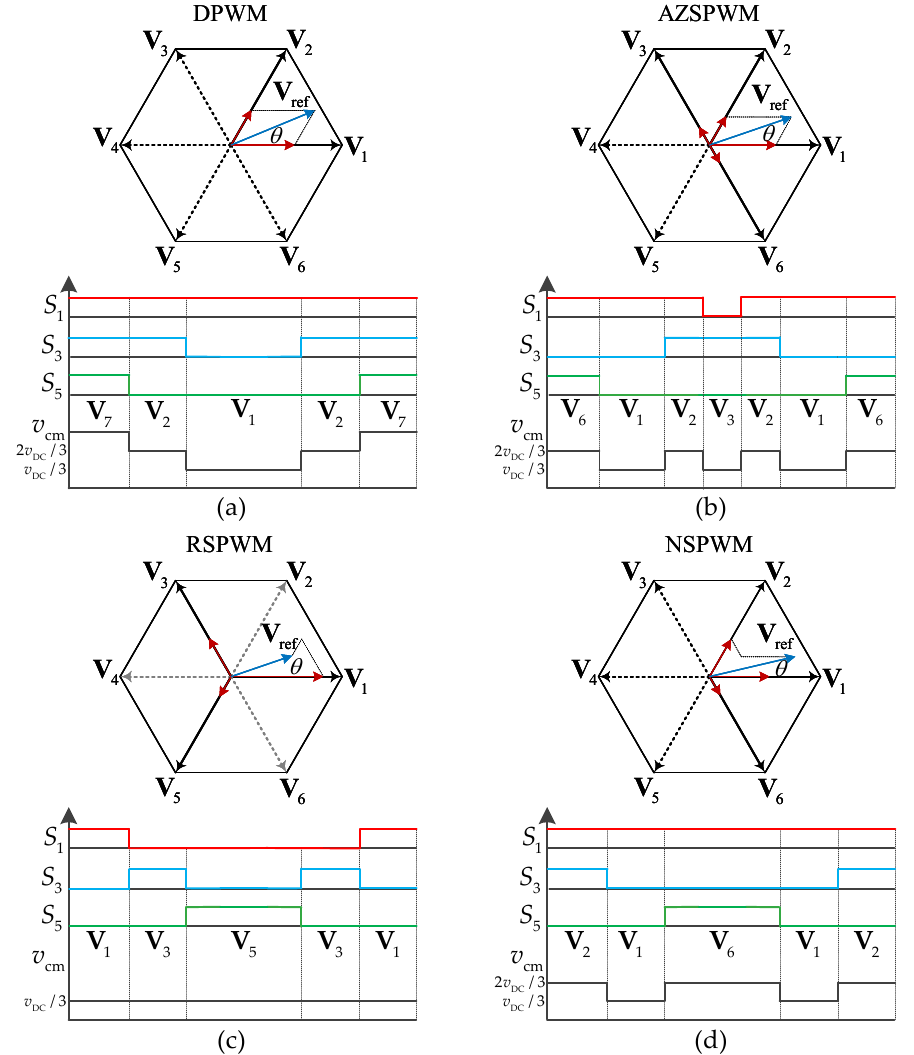
Figure 4. Typical CMV reduction strategies with switching patterns and CMV when using: ( a ) discontinuous pulse width modulation (DPWM), ( b ) active zero state pulse width modulation (AZSPWM), ( c ) remote state pulse width modulation (RSPWM) and ( d ) near state pulse width modulation (NSPWM)